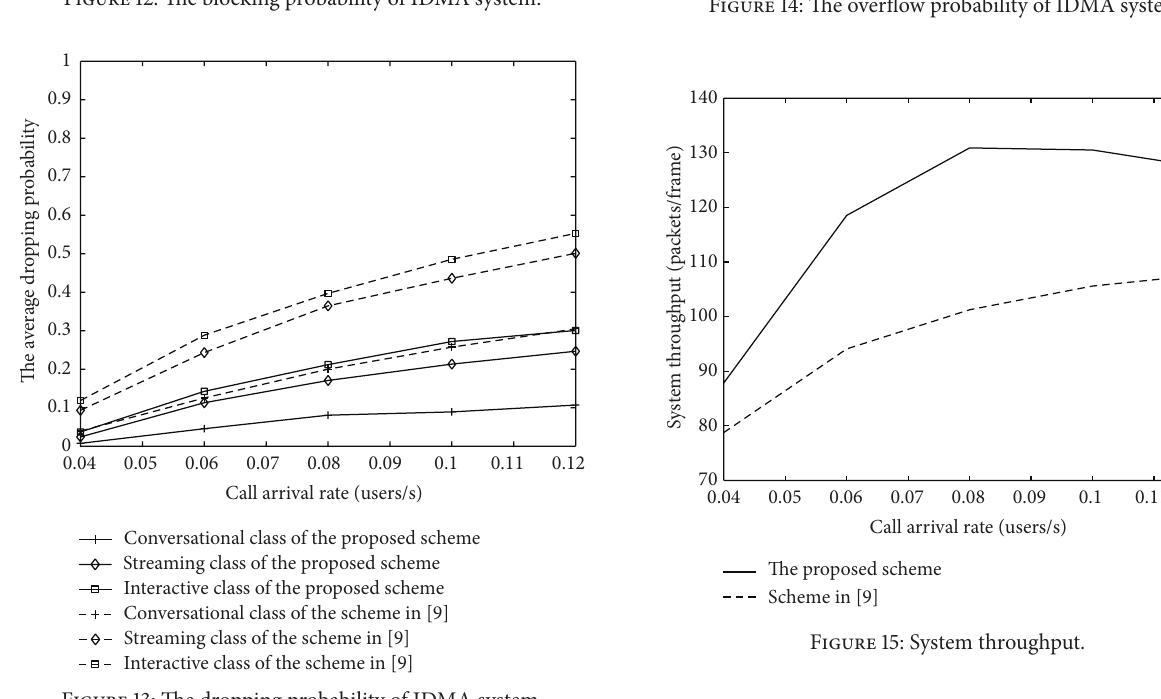
Figure 14: The overflow probability of IDMA system.